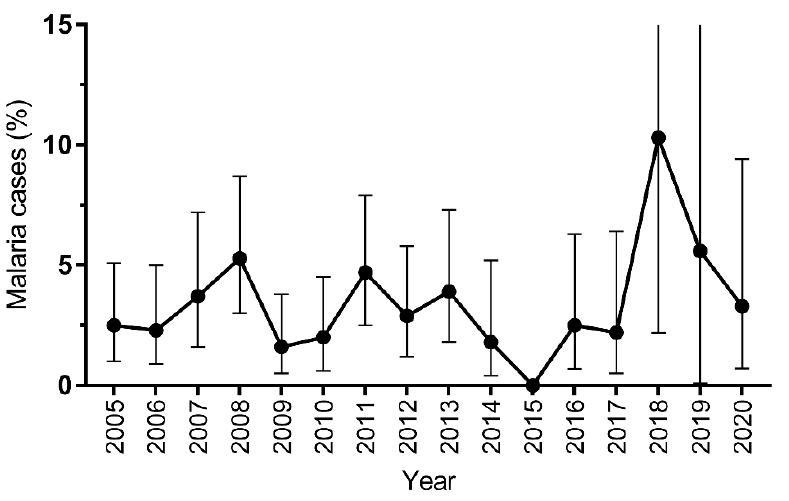
Figure 1. Trend in malaria cases at University Hospital of the National University of Malaysia (UKM) from 2005 to 2020. Error bar represents 95% confidence interval (CI)